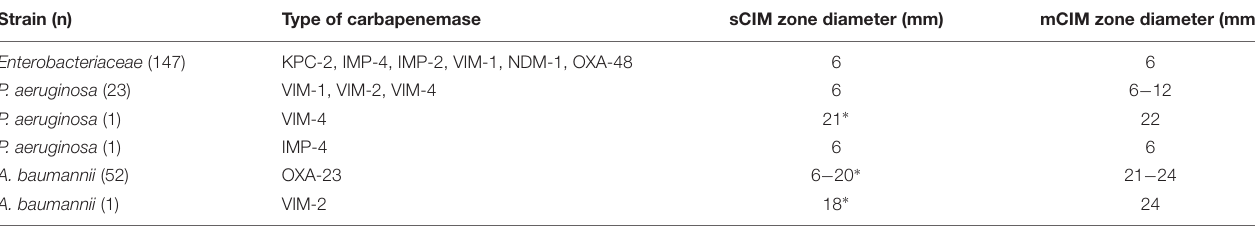
TABLE 4 | Comparison of sCIM and mCIM results for selected strains. Strain